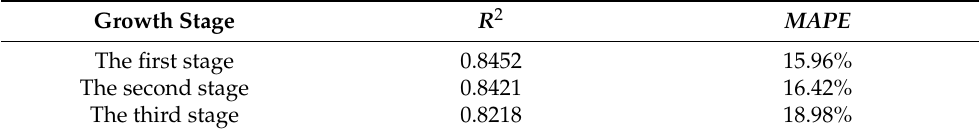
Table 9. R 2 and MAPE for the random forest fresh weight